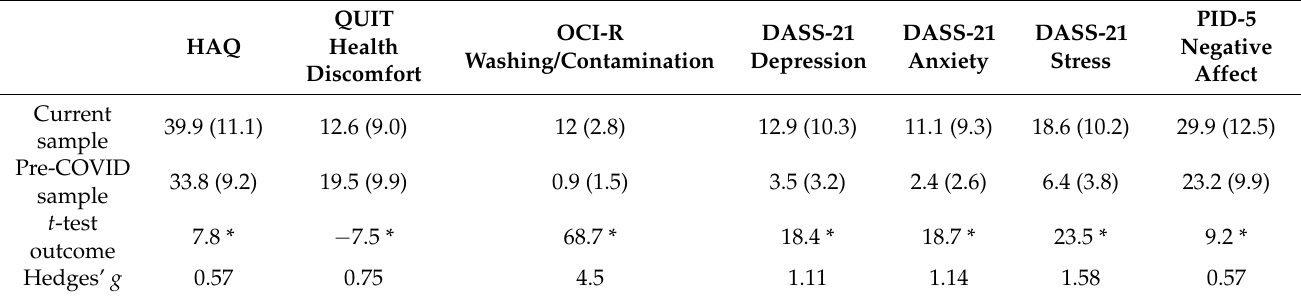
Table 3. Comparison between the current sample and the original Italian standardization sample on various measures of